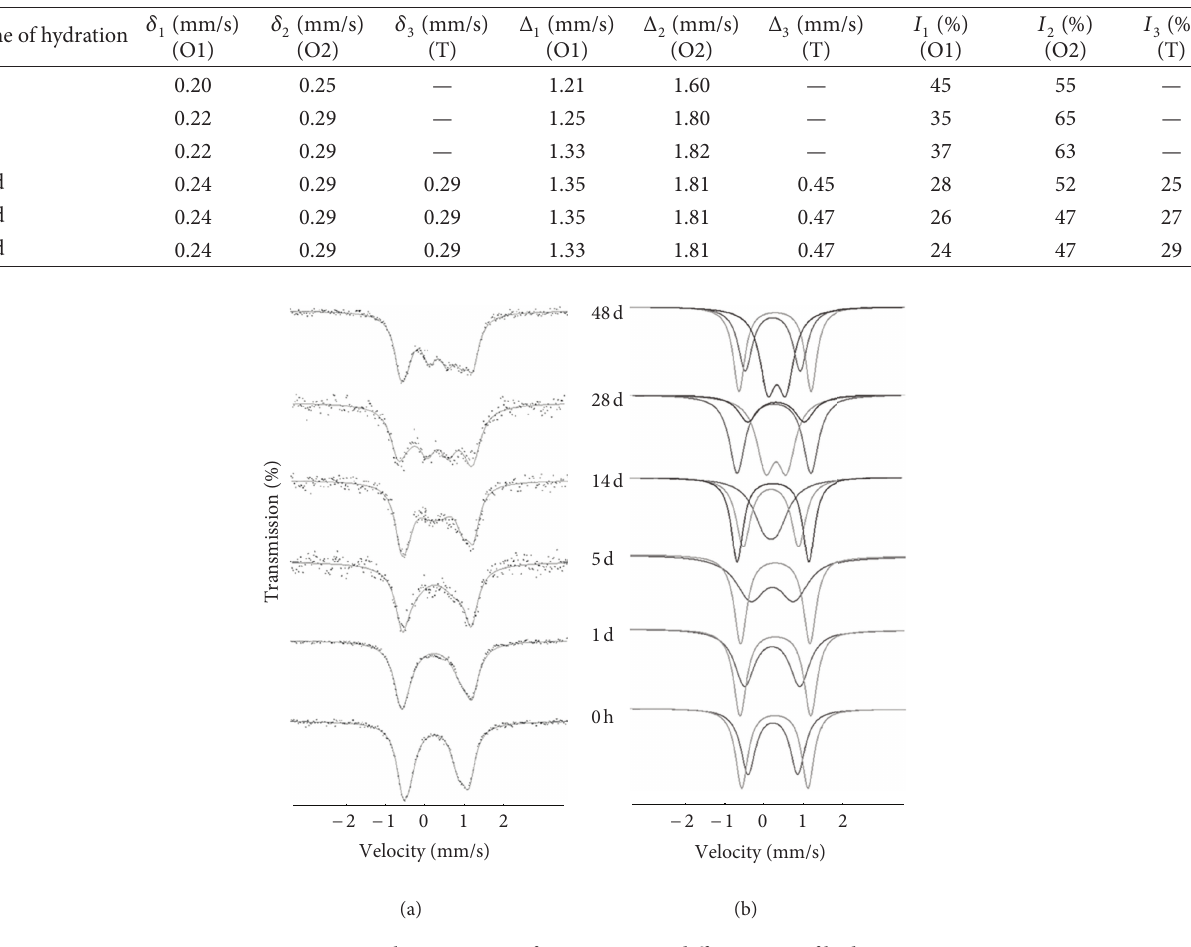
F 5: Mössbauer spectra of cement PC1 at different ages of hydration. T 7: Mössbauer parameters of the of cement PC1FA at different ages of hydration.